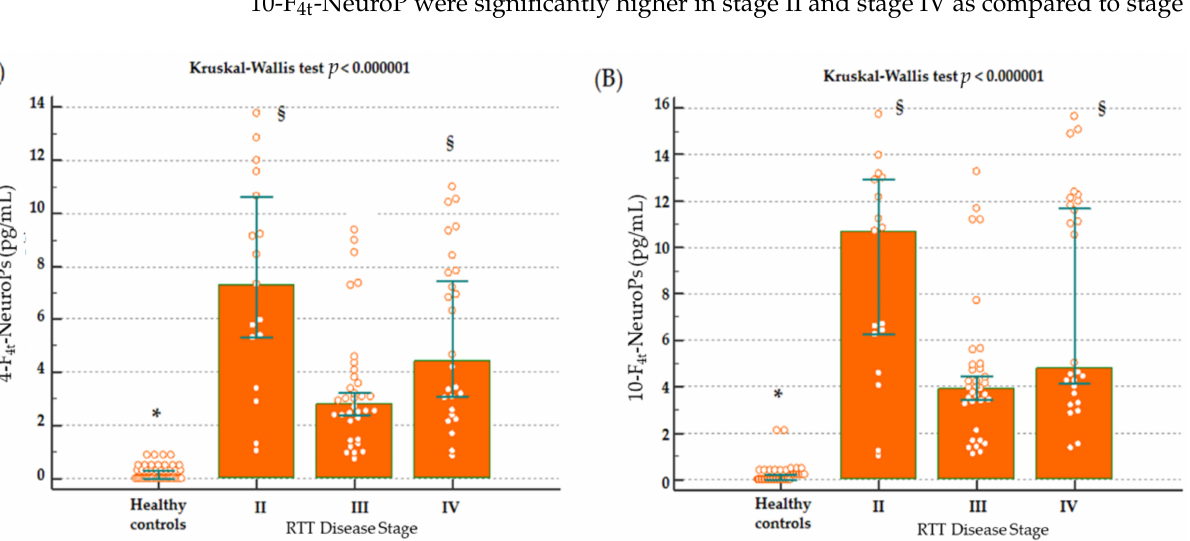
Figure 1. Plasma levels of 4-F 4t -NeuroP ( A ) and 10-F 4t -NeuroP ( B ) as a function of RTT disease stage. Data are shown as medians (columns) and interquartile ranges (25th–75th percentiles). RTT subjects: n = 77, Healthy controls n = 45. * different from stages II, III, and IV; § different from Stages III and healthy controls, post-hoc analysis, Conover test, p <